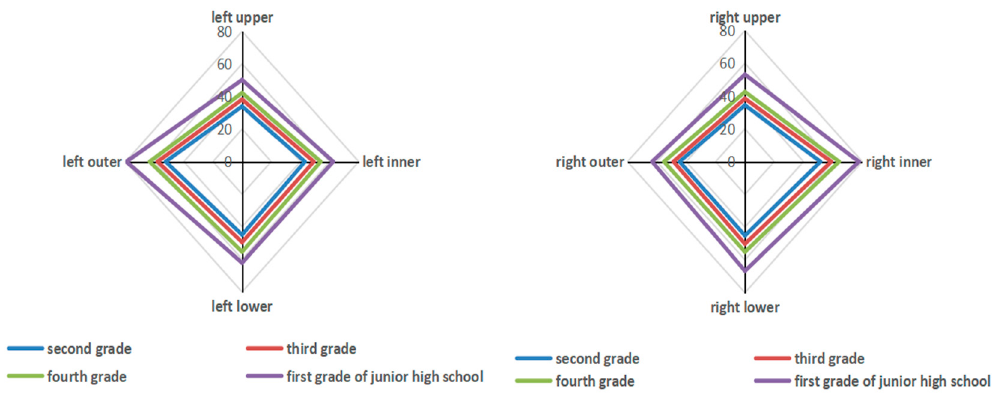
Figure 2. Horizontal comparison of students’ left and right eye visual fields in each grade at Assessment 1.